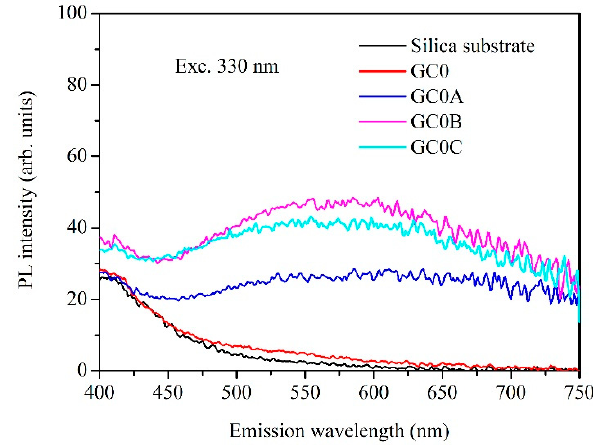
Figure 3. Photoluminescent (PL) emission by 330 nm excitation of undoped samples before Ag-exchange (GC0), after exchange (GC0A), and after annealing at 380 °C (GC0B) and 430 °C (GC0C). The broad emission, up to 750 nm and more, is reasonably attributed to Ag multimers and small aggregates.